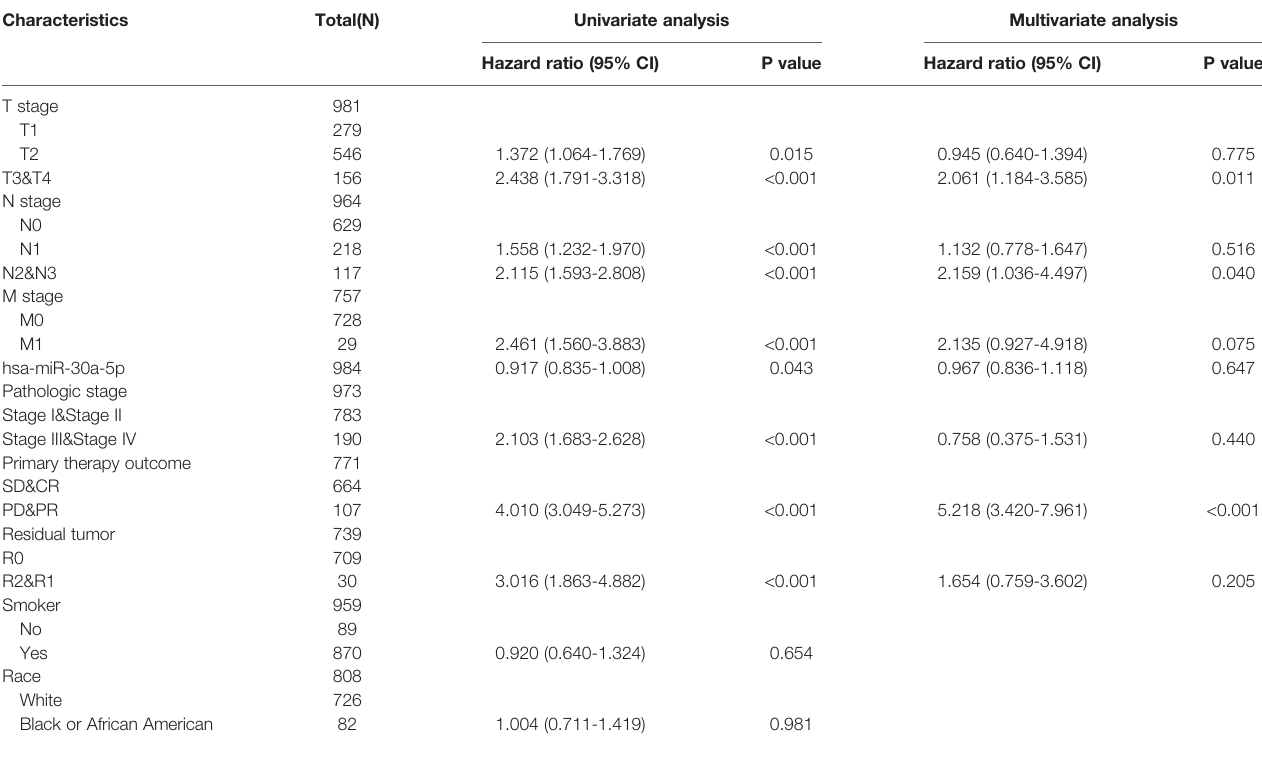
TABLE 3 | Univariate regression and multivariate survival model of prognostic covariates in patients with LUAD.